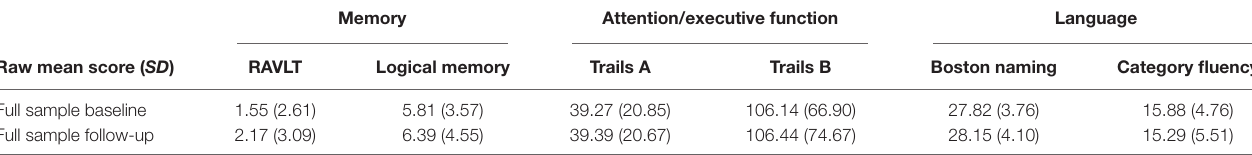
TABLE 1A | Descriptive statistics among participants at baseline and